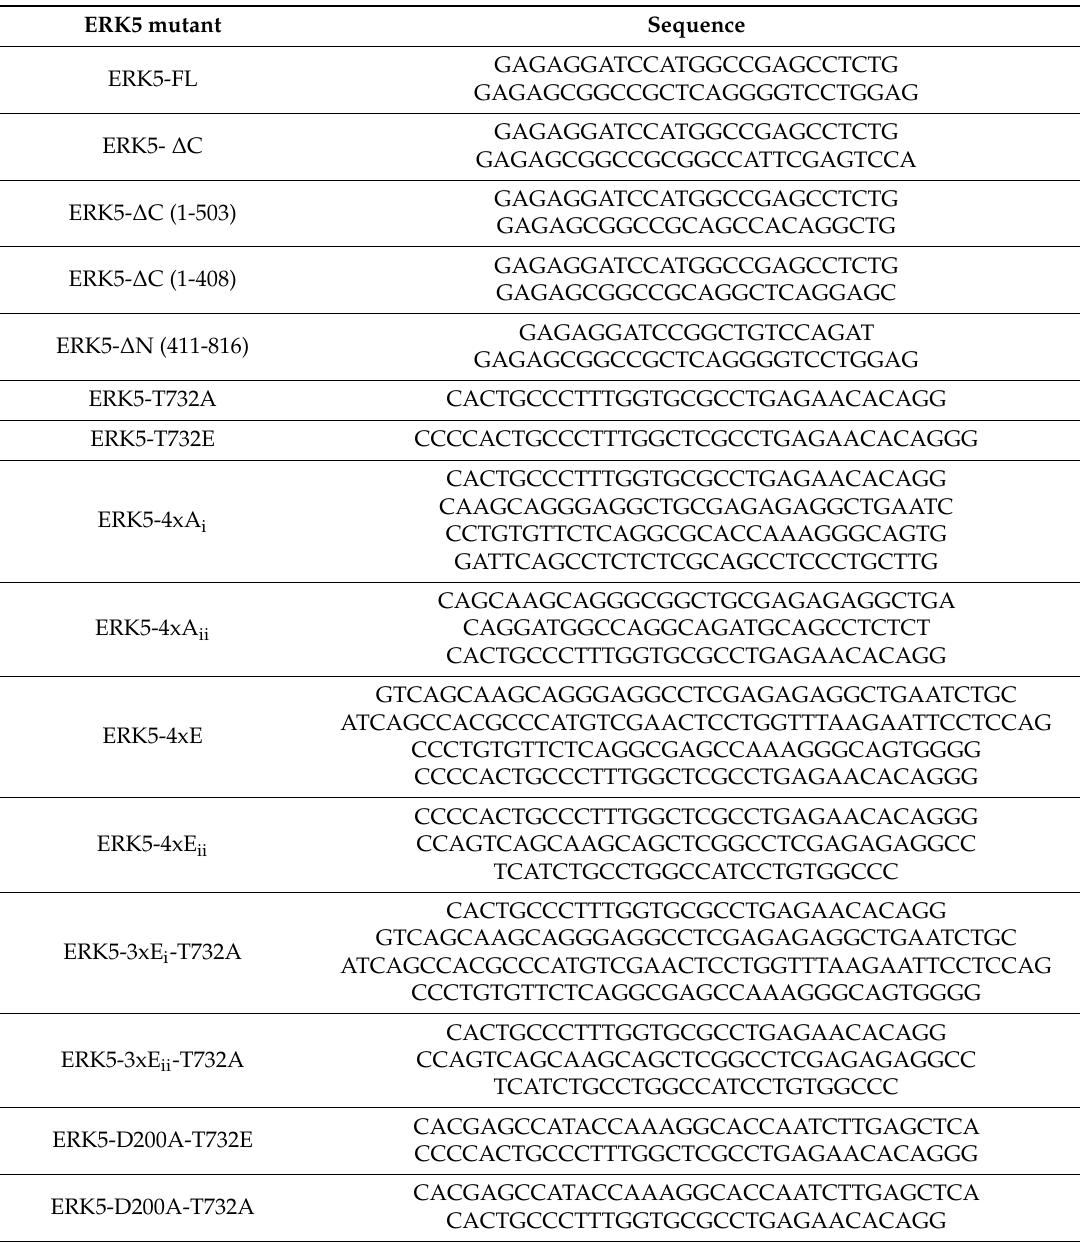
Table 2. Primer sequences used for mutagenesis and